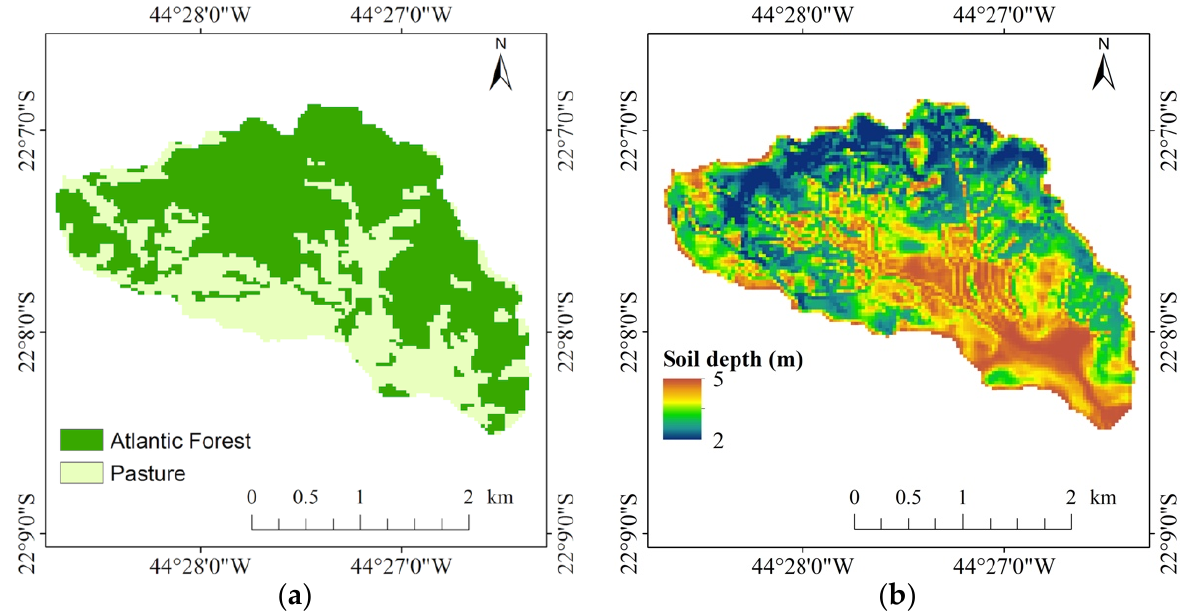
Figure 2. Land cover map in the Lavrinha Creek Watershed ( a ) and soil depth map ( b ).